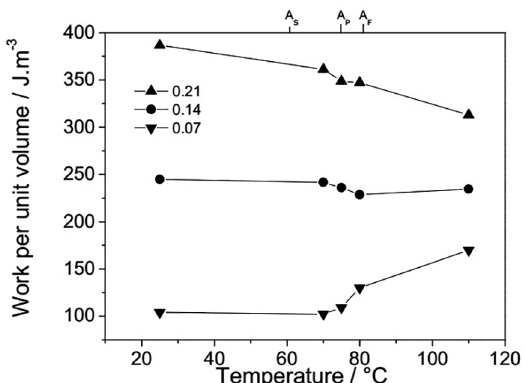
Figure 5. The total drawing work as a function of drawing temperature for the solution treated 2.080 mm diameter wire, drawn in a single pass of 0.07, 0.14, and 0.21 mm 2 .mm -2 area reduction.